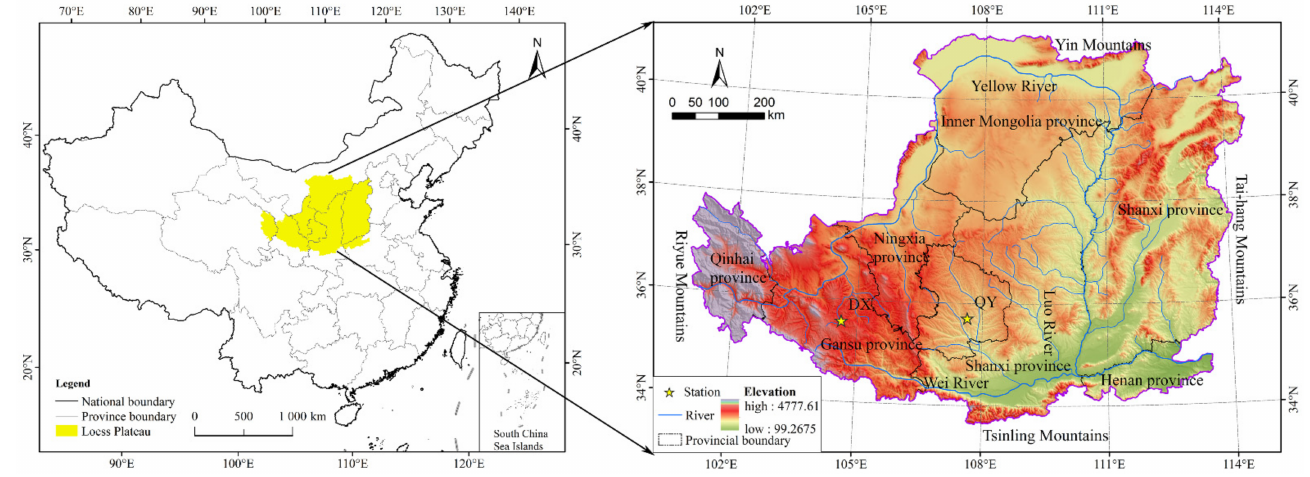
Figure 1. Geographical location of the study area. The stars show the Dingxi and Qingyang